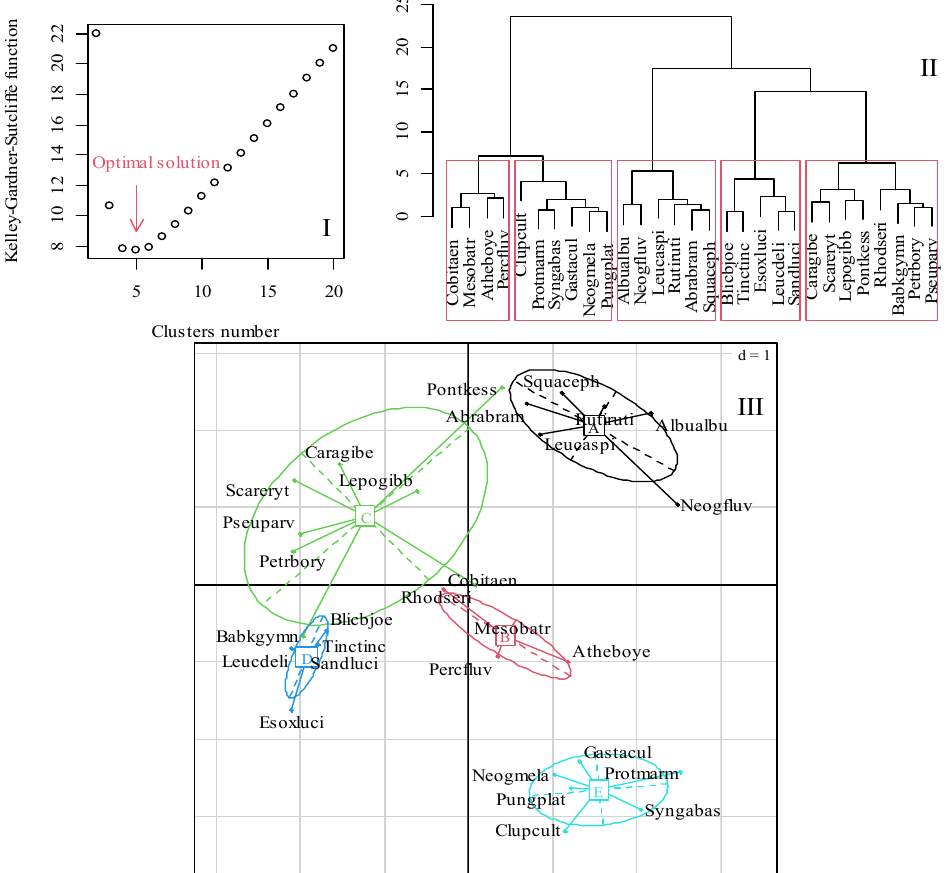
Figure 6. ( I ): Location of species in the RLQ space of axes 1 and 2 (( II ): box is a hierarchical